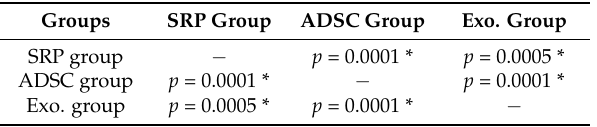
Table 2. Pairwise comparison of mean area % values of newly formed tissues for the studied groups after 2 days (post hoc Tukey test).